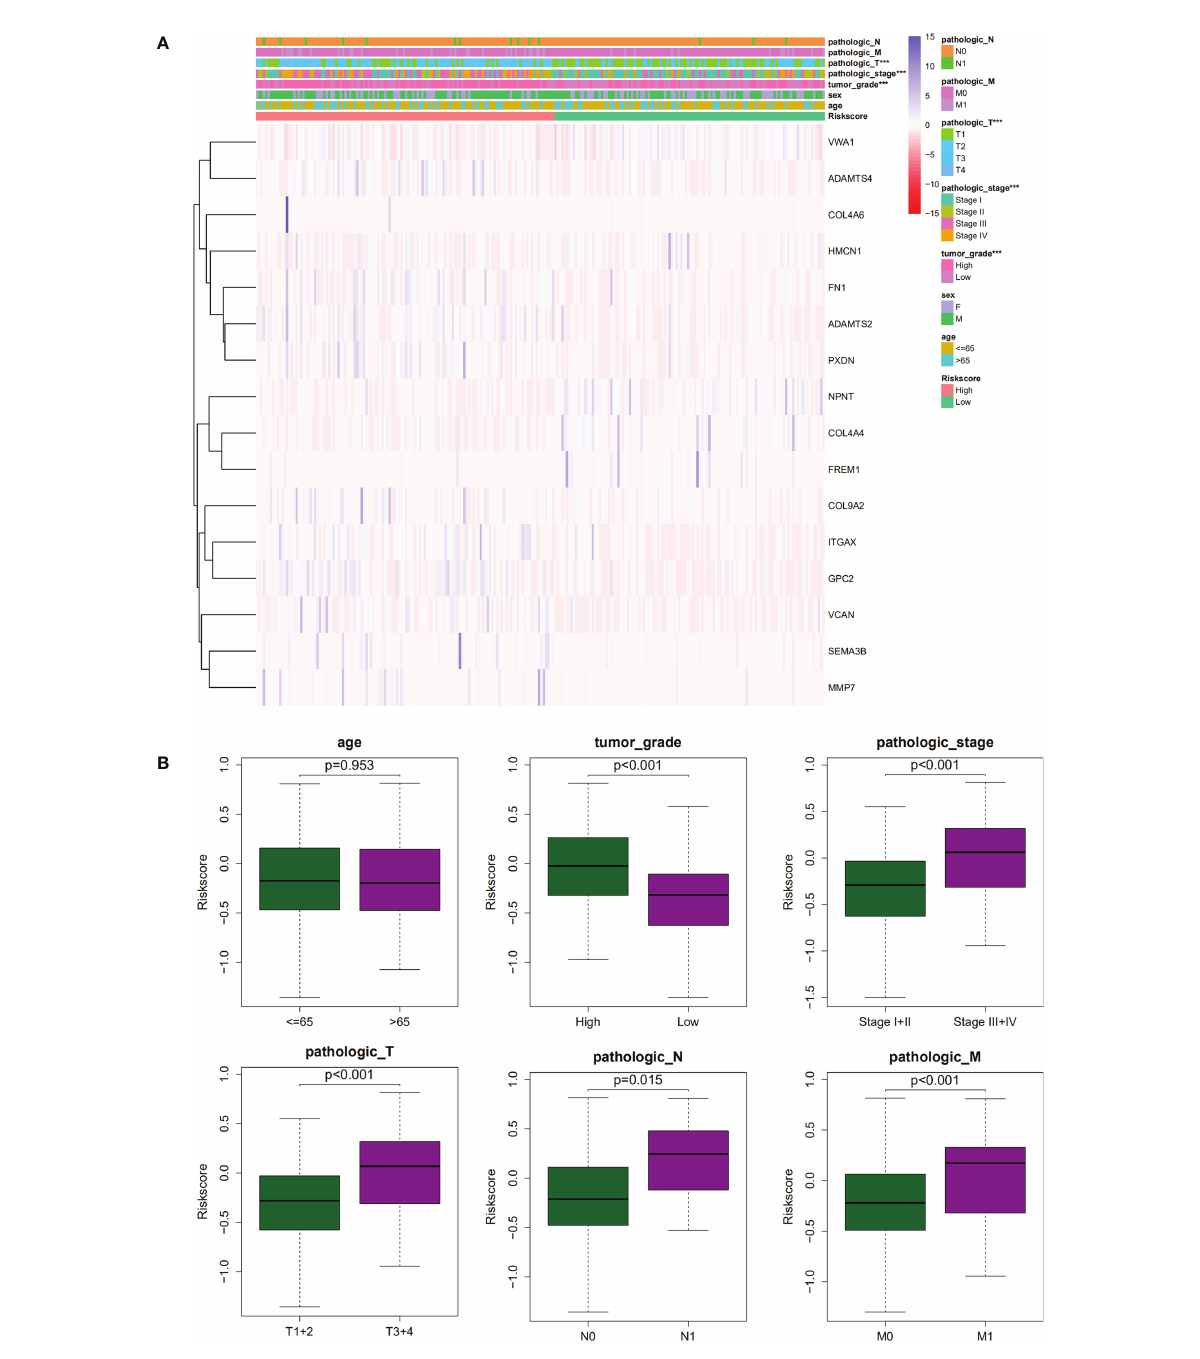
FIGURE 7 (A, B) . The correlations between clinicopathological features and the gene